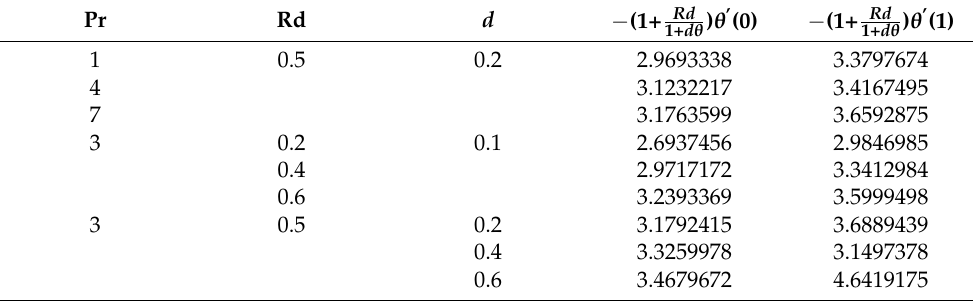
Table 3. Numerical values for heat transfer rate.